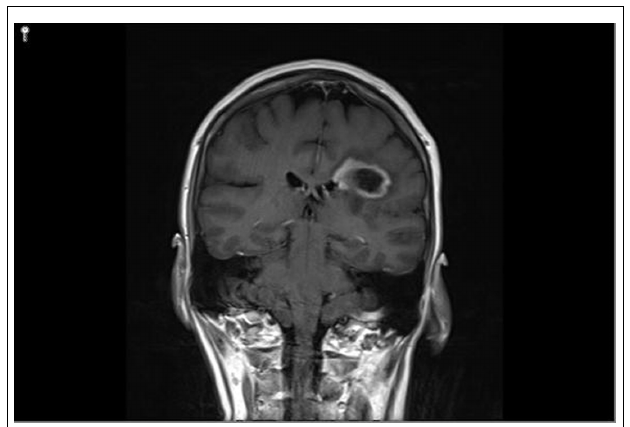
FIGURE 2 | Coronal post-gadoliniumT1-weighted MRI shows a mass in the subcortical left frontoparietal region abutting into the left lateral ventricle with associated peripheral ring-like enhancement.